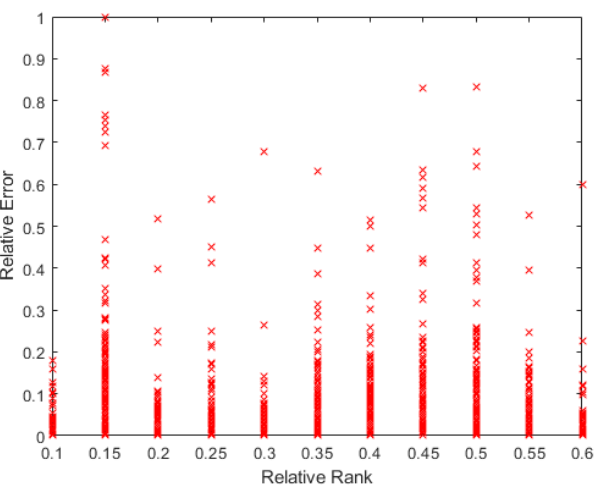
Figure 14. Pattern distribution according to their Relative Error and Relative Rank in X 2 .